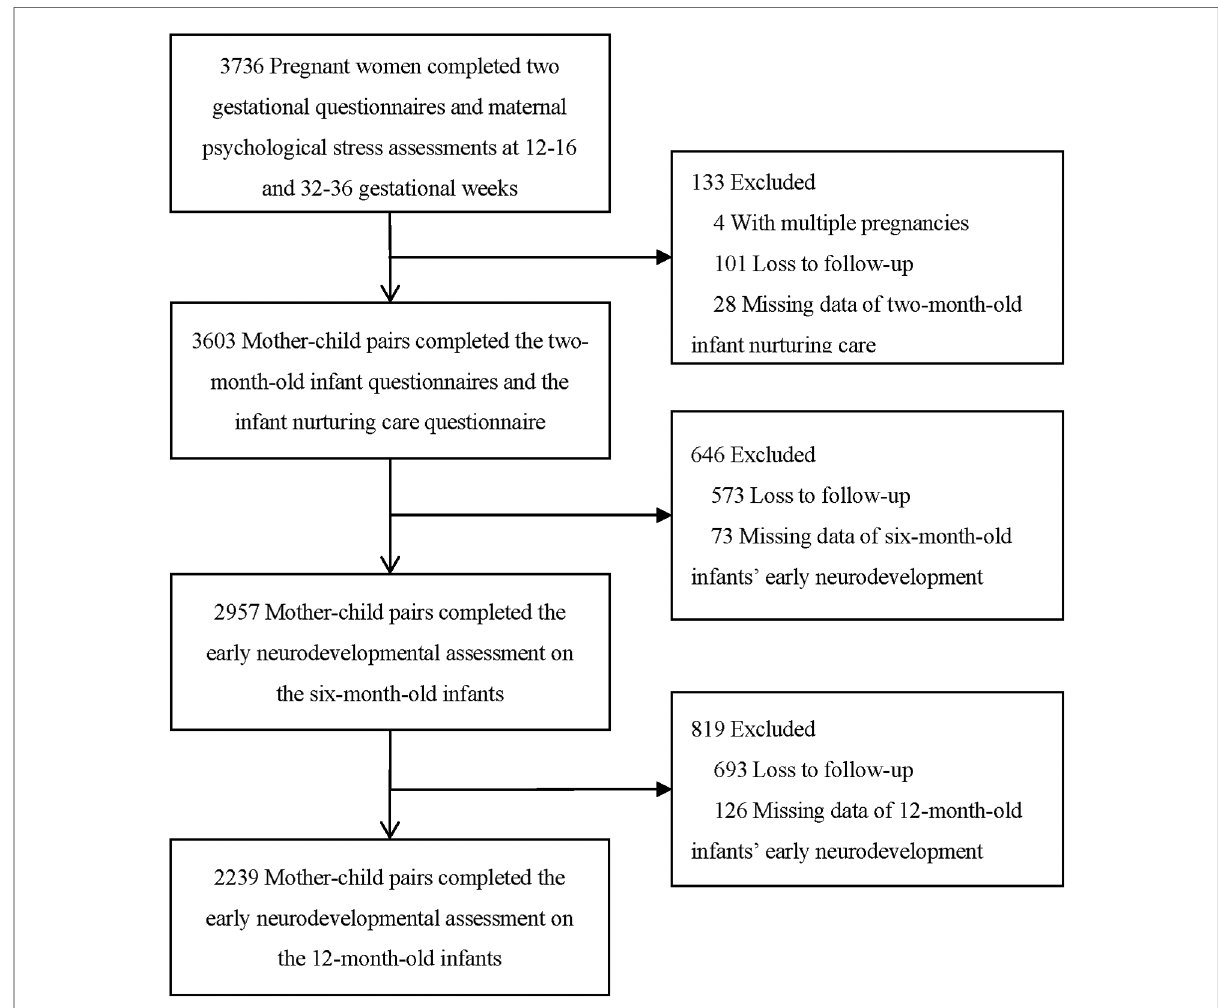
FIGURE 1 Flowchart describing the selection process for the pregnant women and the follow-up on their